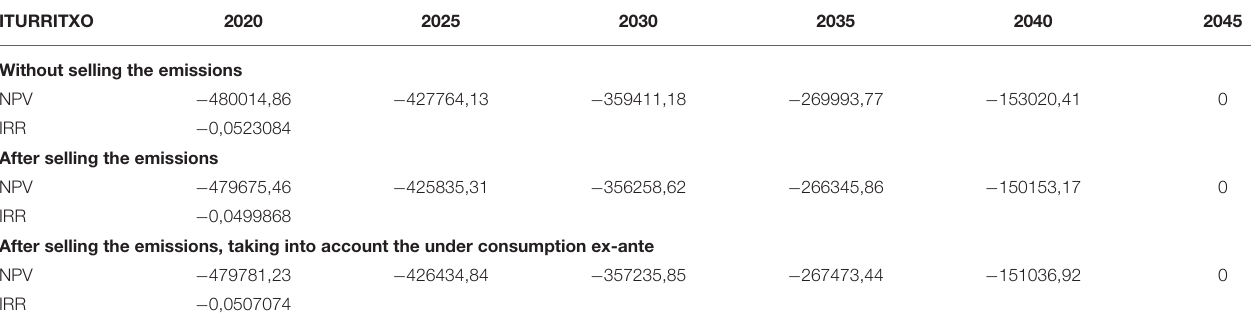
TABLE 4 | NPV and IRR for the installation of the solar thermal system in ITURRITXO.